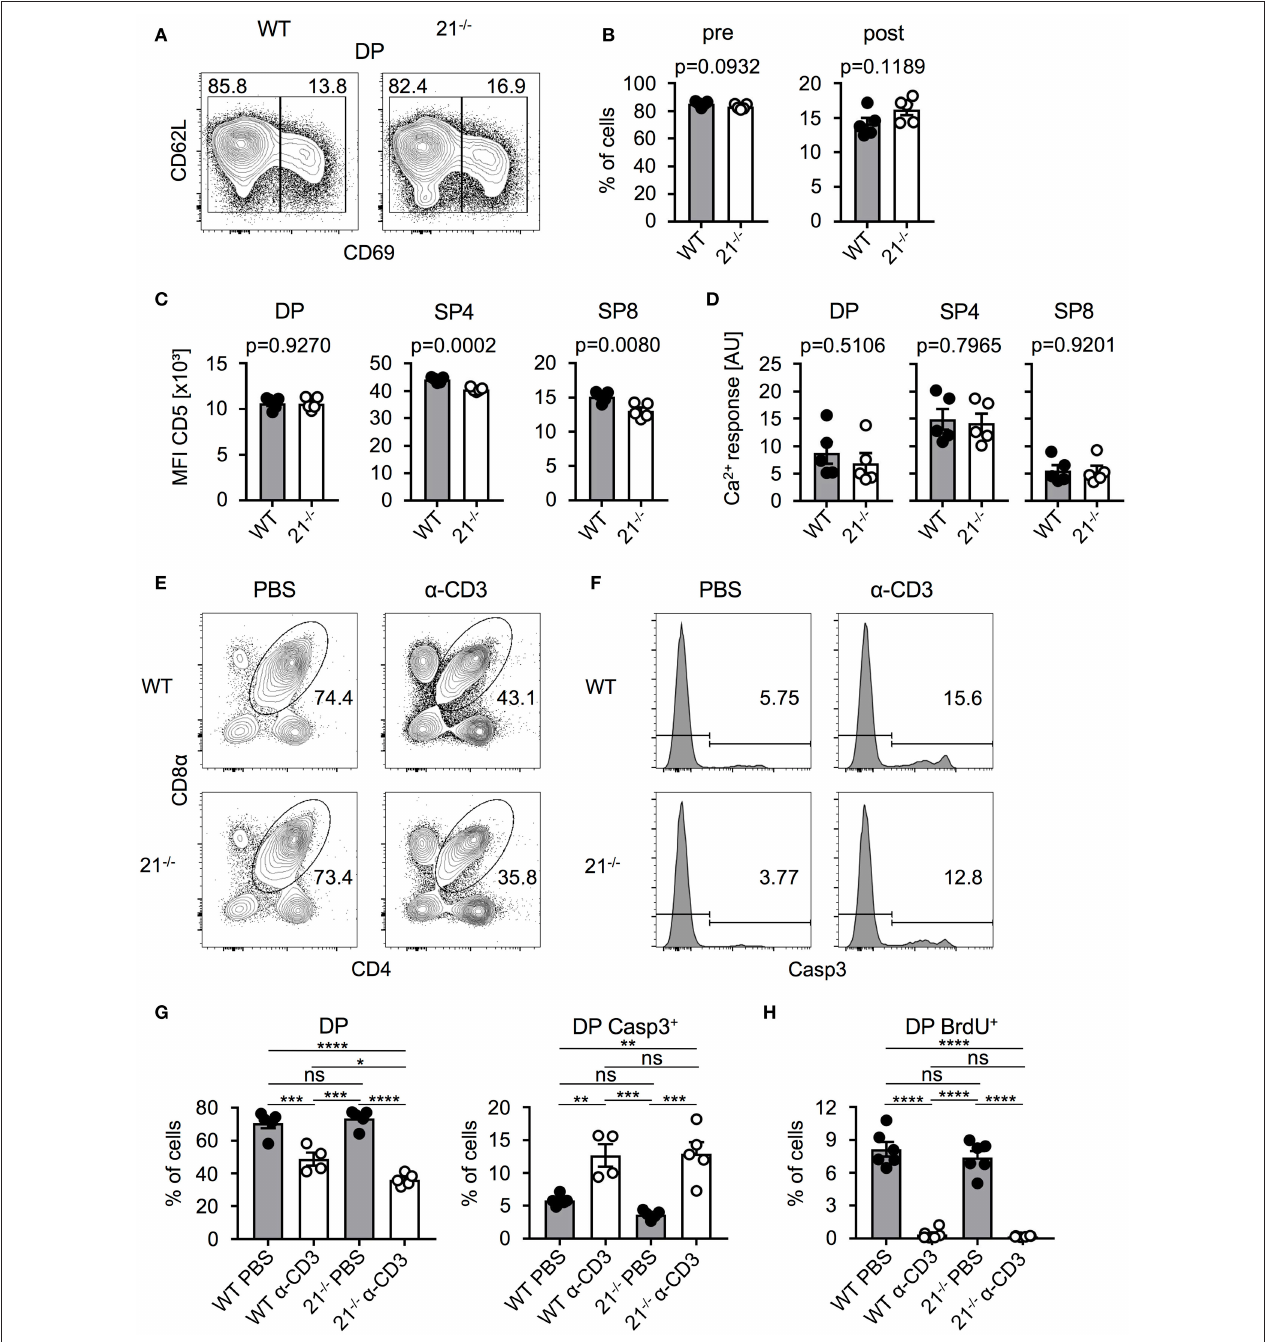
FIGURE 3 | Absence of miR-21 does not affect negative selection. (A) Representative flow cytometric analysis of thymi from WT and miR-21 − / − mice stained with antibodies against CD4, CD8 α , CD69 and CD62L. Numbers in left and right corners represent frequencies of pre- and post-selection DP, respectively. (B) Statistical analysis of flow cytometric results shown in (A) , n = 5. (C) Statistical analysis of mean fluorescence intensity of CD5 on DP, SP4 or SP8, n = 5. (D) Statistical analysis of resulting Ca 2 + -response upon stimulation in DP, SP4 and SP8 thymocytes, n = 5. (E) Representative flow cytometric analysis of thymi from WT and miR-21 − / − mice, 48h post injection with either PBS or α -CD3, stained with antibodies against CD4 and CD8 α . Numbers adjacent to gates represent frequency. (F) Histograms display expression of active caspase-3 in DP thymocytes from WT and miR-21 − / − mice, 48 h post injection with either PBS or α -CD3, n = 4-5 per group. (G) Statistical analysis of flow cytometric results shown in (E,F) . Analysis of significance were performed using one-way analysis of variance followed by Tukey’s test. Indicated significant results are representative of latter test. (H) Statistical analysis of BrdU + DP thymocytes of thymi from WT and miR-21 − / − mice, 48h post injection with either PBS or α -CD3, n = 6 for each genotype. Pooled data of two independent experiments.